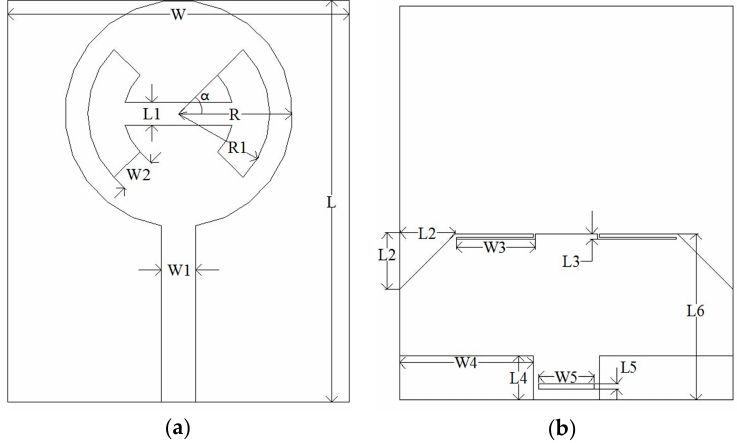
Figure 1. Schematic configuration of the proposed tri-band-notched antenna: ( a ) Patch; ( b ) Ground Plane. Table 1. Design Parameters of the Proposed UWB Antenna (mm).